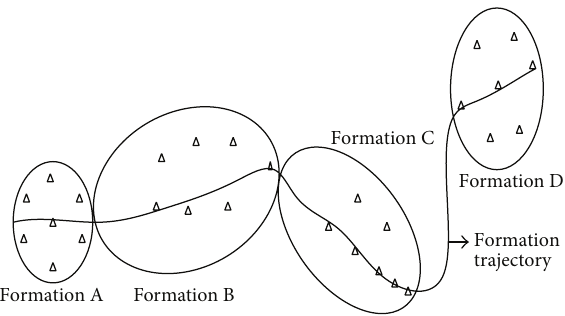
Figure 1: Multi-UAV formation autonomous reconfiguration pro-